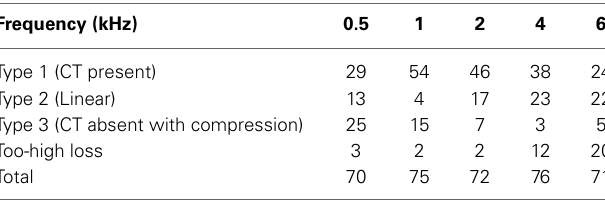
Table 2 | Number of I/O curves according to their